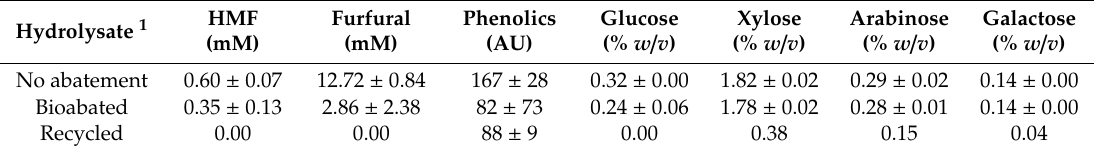
Table 2. Composition of corn stover dilute-acid hydrolysate and abatement of inhibitors.